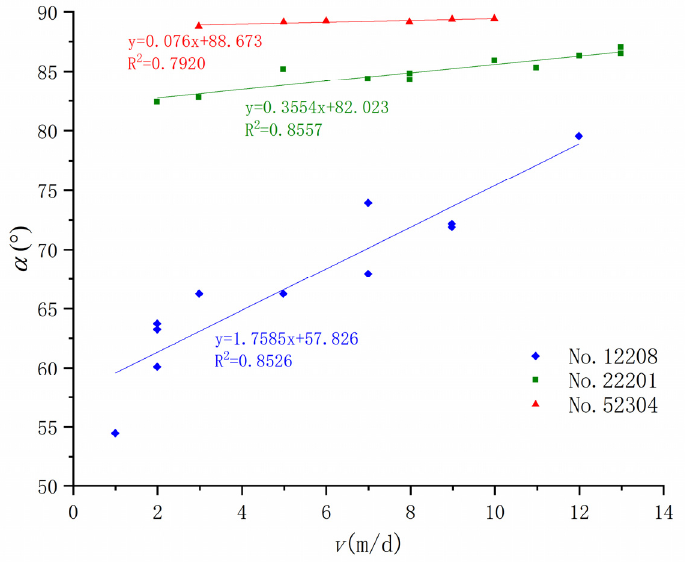
Figure 11. Relationship between ground fissure advance rate v and angle α .